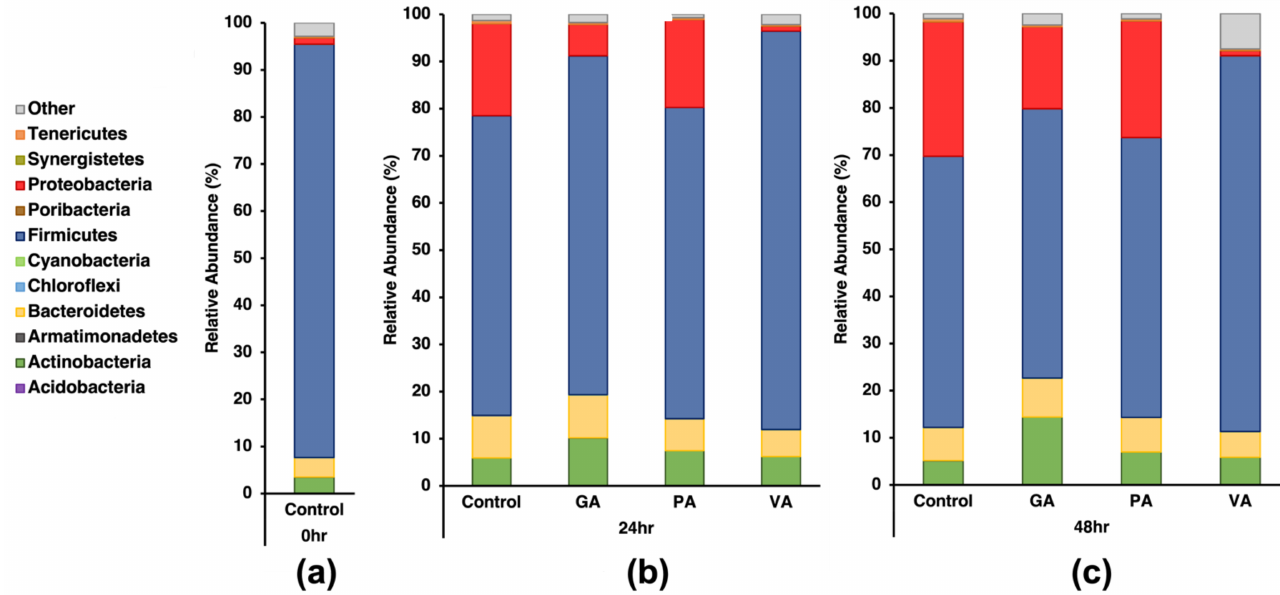
Figure 2. Relative percentage of abundance of microbes at the phylum level for the top 12 phyla in 16S-rRNA gene sequencing data at 0 h ( a ), 24 h ( b ), and 48 h ( c ) for an untreated control and groups individually treated with either gallic acid (GA), protocatechuic acid (PA) and vanillic acid (VA).